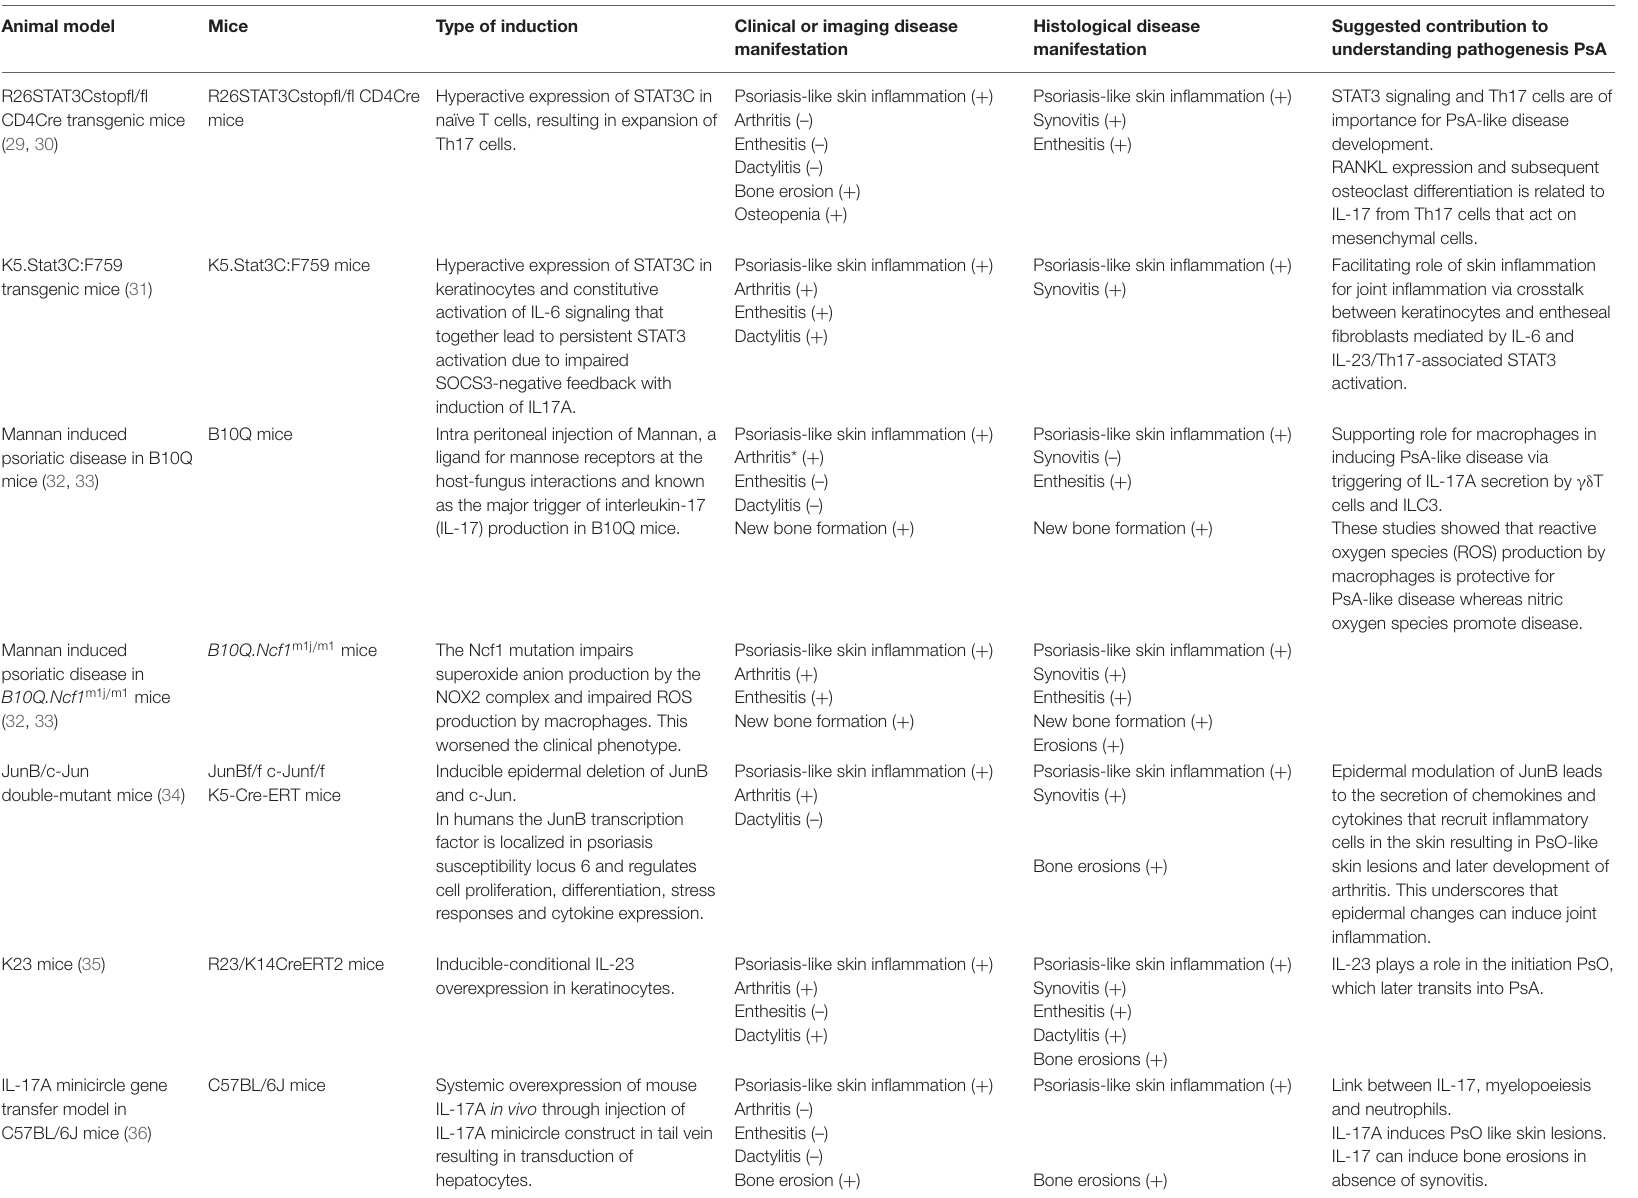
TABLE 1 | Characteristics of animals models for psoriatic arthritis and their contribution to understanding disease